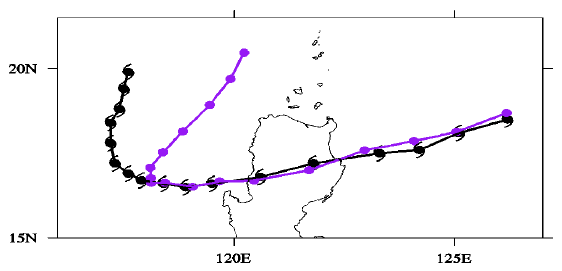
Figure 1. Simulated typhoon track by CTRL (in purple) compared with the observed track (in black).